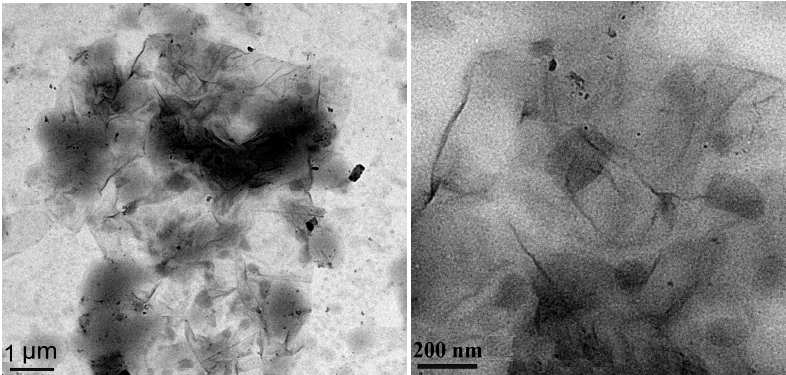
Figure 9. TEM microphotographs of SGO/WPU.